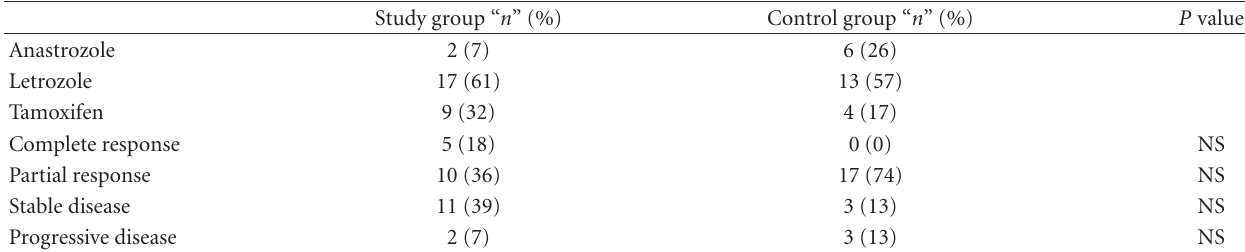
Table 2: Choice of endocrine therapy and initial response to endocrine